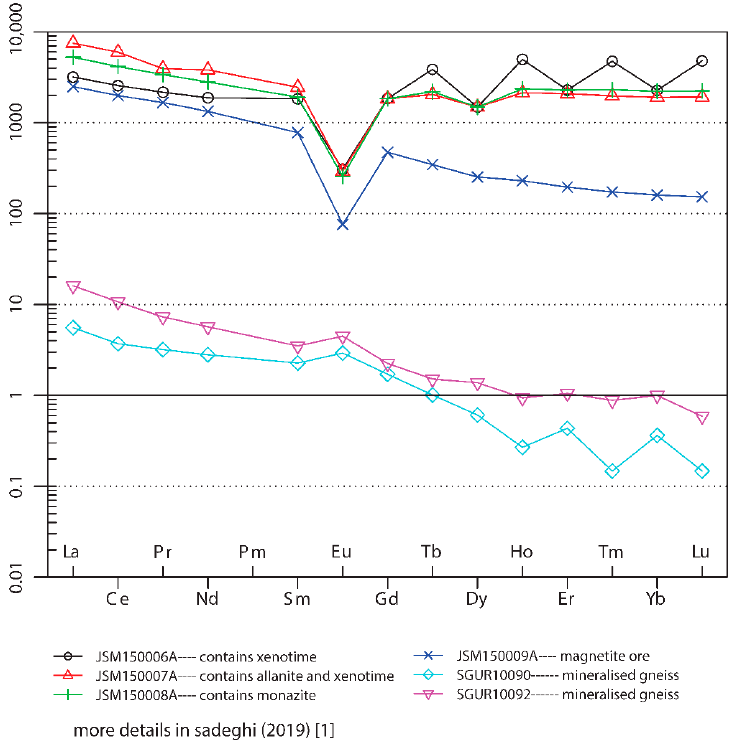
Figure 9. Primitive mantle-normalized [37] REE diagram of iron oxides of unknown origin.